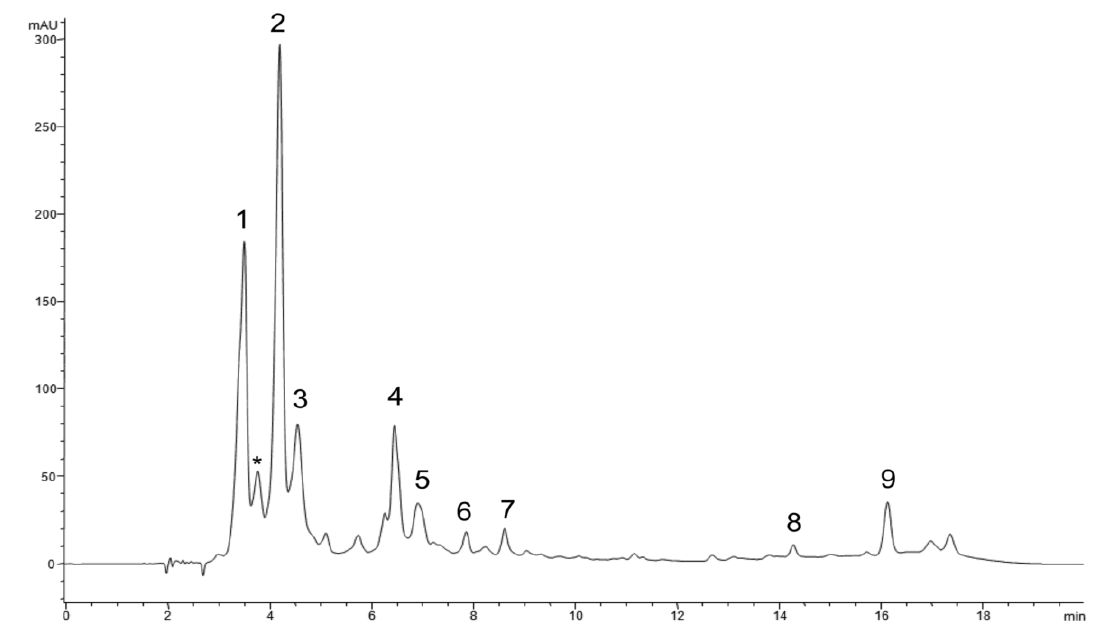
Figure 5. High performance liquid chromatography with diode array detector (HPLC-DAD) chromatogram of hydroethanolic extract of highbush blueberry cv. Bluegold. Chromatogram was registered at 280 nm; * background of detector, does not present a UV spectra.